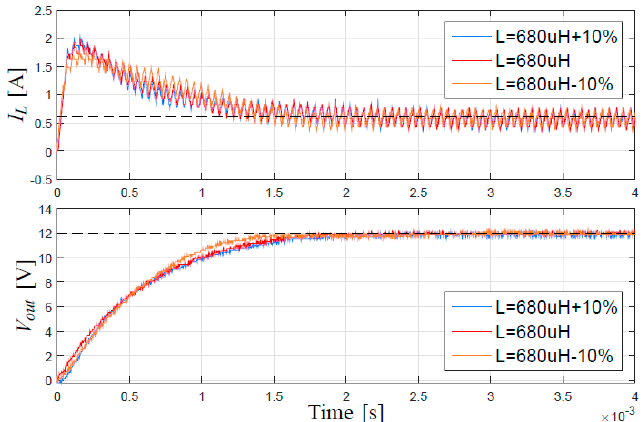
Figure 17. Step responses with the proposed design procedure when the model value of the inductor is set to 680 μ H − 10% and 680 μ H+10%.